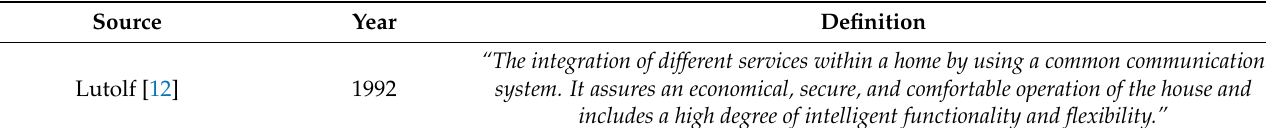
Table 1. Literature review of representative definitions regarding smart